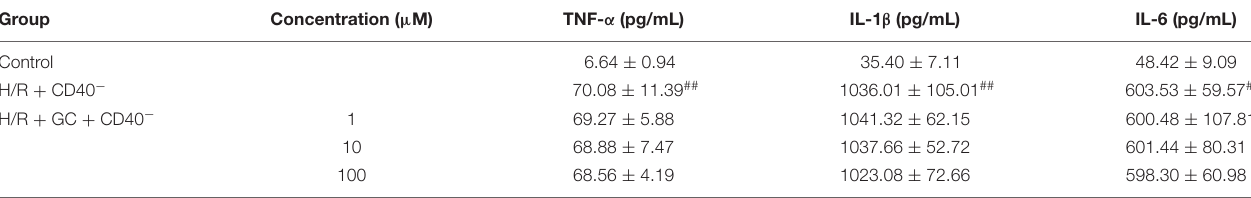
TABLE 3 | Effects of GC on the supernatant inflammatory cytokines of ventricular myocytes under the condition of CD40 gene silencing.